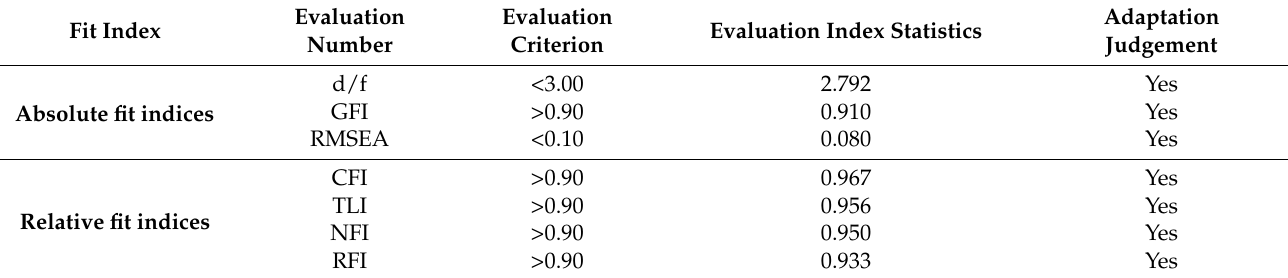
Table 8. Test result of overall fit of structural equation